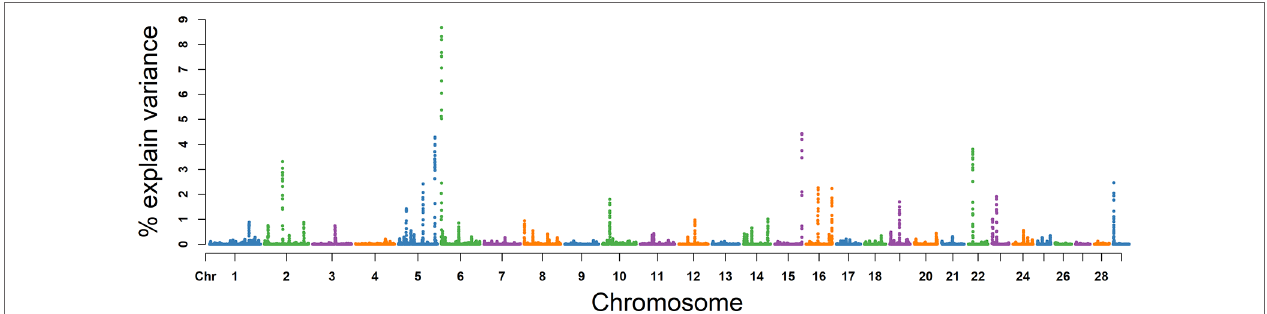
FIGURe 4 | GWAS results of ejaculate volume (VE) in Holstein bulls of China. Each dot represents one SNP. The X-axis represents 29 autosomes, respectively. The Y-axis represents the percentage of genetic variance explained by SNP.